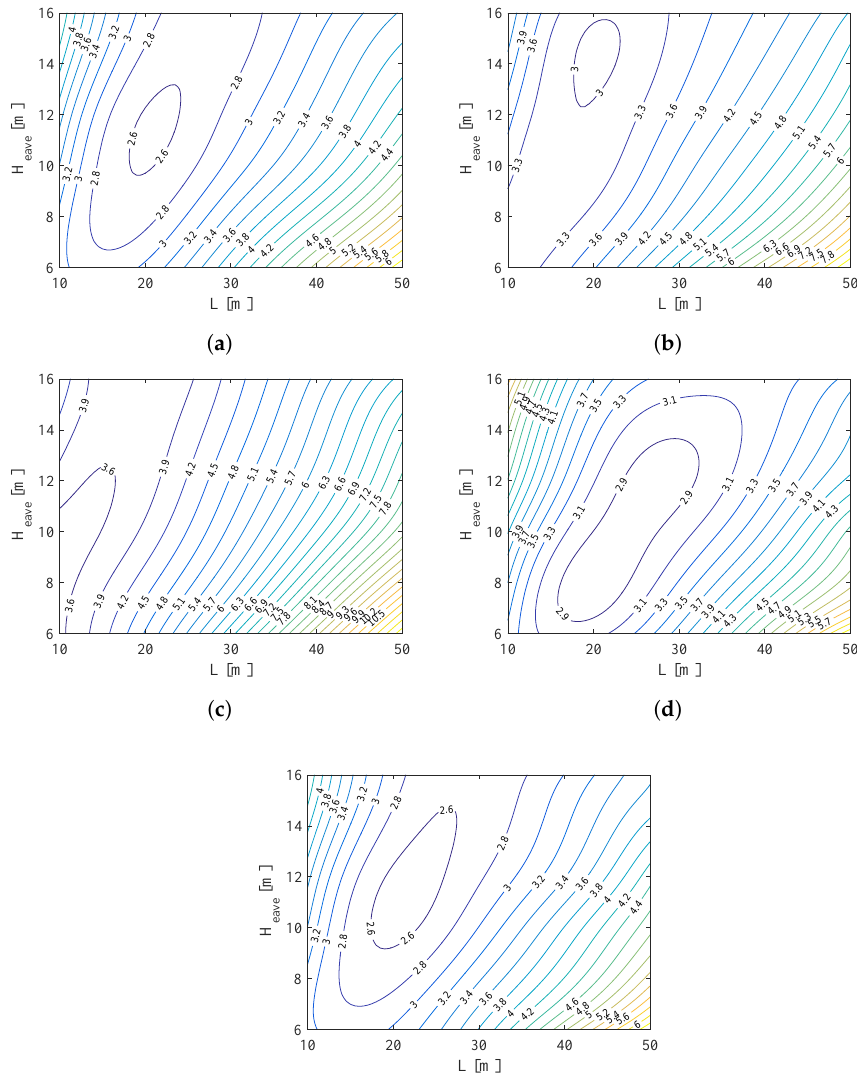
Figure 2. Contours of optimal frame ECI (kgCO 2 /m 3 ) for Model 4: ( a ) Detroit, MI; ( b ) St. Paul, MN; ( c ) Berlin, NH; ( d ) Miami, FL; ( e ) St. Charles,